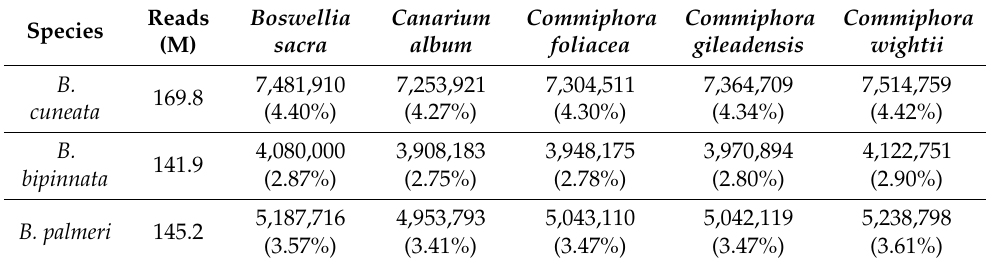
Table 3. Alignment and mapping of the preprocessed filtered reads of the three Bursera species against the chloroplast genomes of five Burseraceae species. The percentages of the total mapped filtered reads are in parentheses.